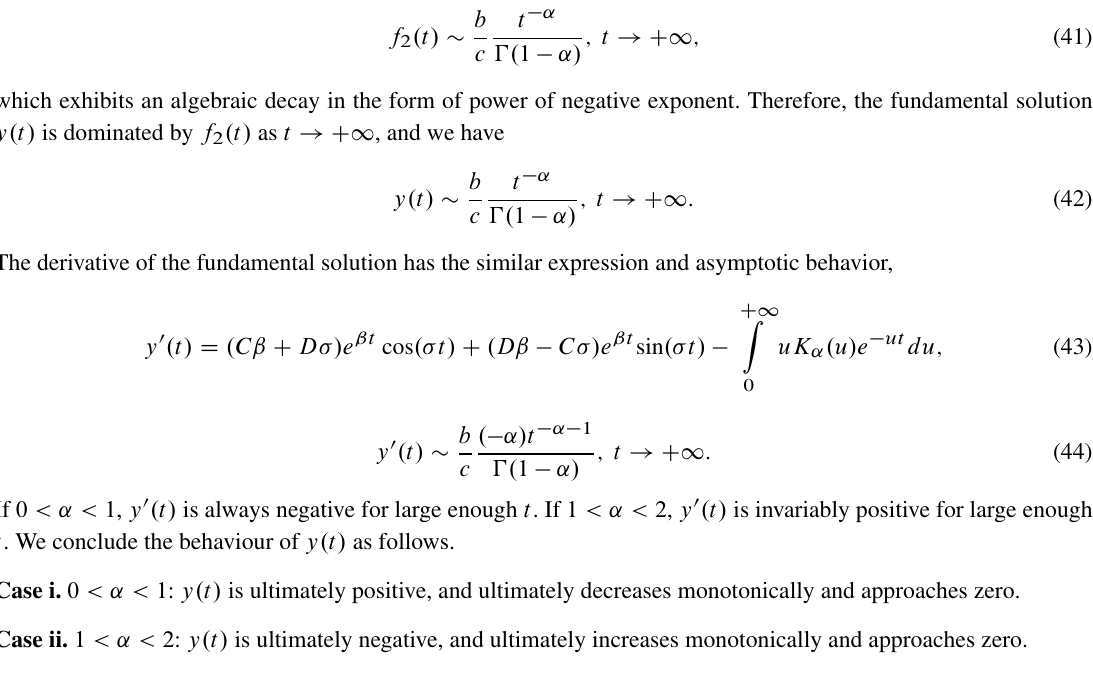
Fig. 7. Curves of y.t/ for b D c D 1 and for ˛ D 0:25 (solid line), ˛ D 0:5 (dash line) and ˛ D 0:75 (dot-dash line).